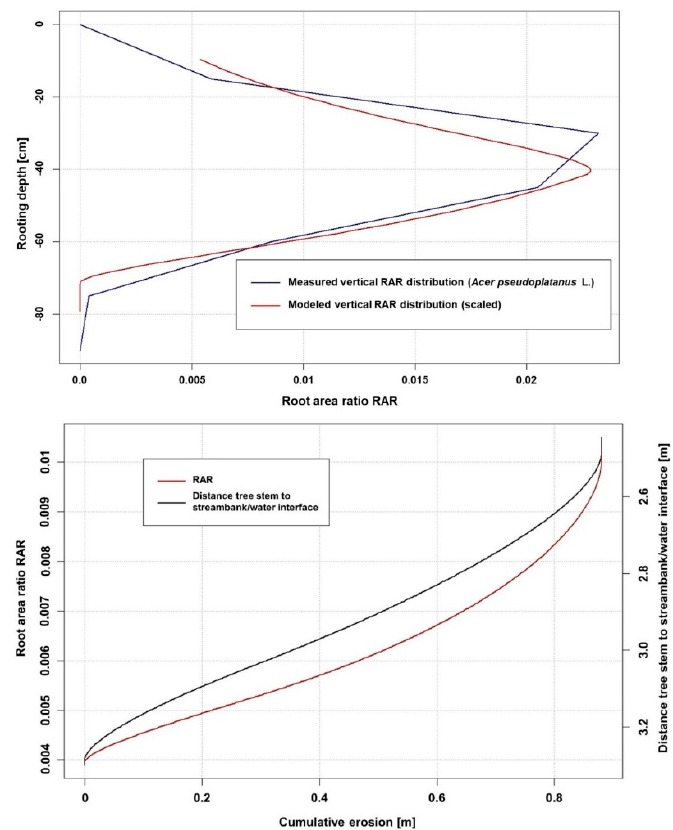
Figure 6. Measured vertical RAR distribution for sycamore maple (Acer pseudoplatanus L., blue) and modeled vertical RAR root distribution for white alder (Alnus incana L.), scaled to represent the measured sycamore maple vertical RAR distribution (red). At the end of both erosion events, the distance of the tree stems to the streambank / water interface was 2.50 m and the DBH was set to 36 cm for both trees ( top ). Modeled RAR for both erosion events at the Sulzigraben catchment considering the adaption of RAR as a function of erosion and the changing distance of the tree stem to the streambank / water interface for the left streambank ( bottom ).